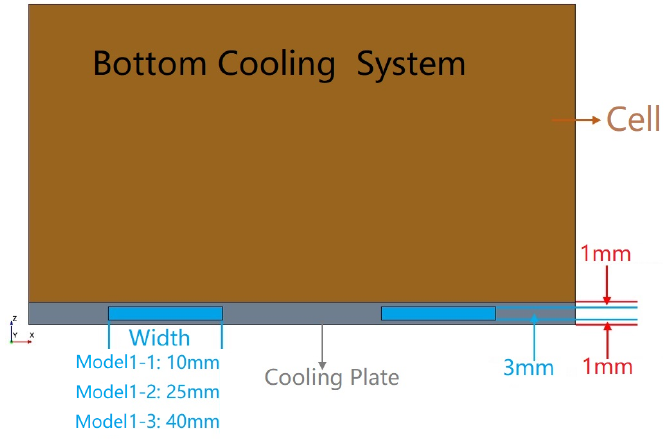
Figure 2. Cross-sectional area of the liquid tube models of the bottom cooling system.